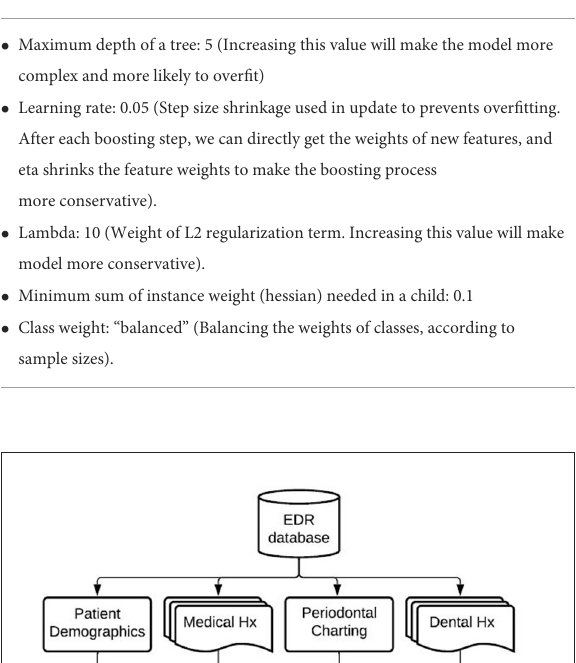
TABLE 4 Optimal hyperparameters of the trained predictive model (XGBoost).